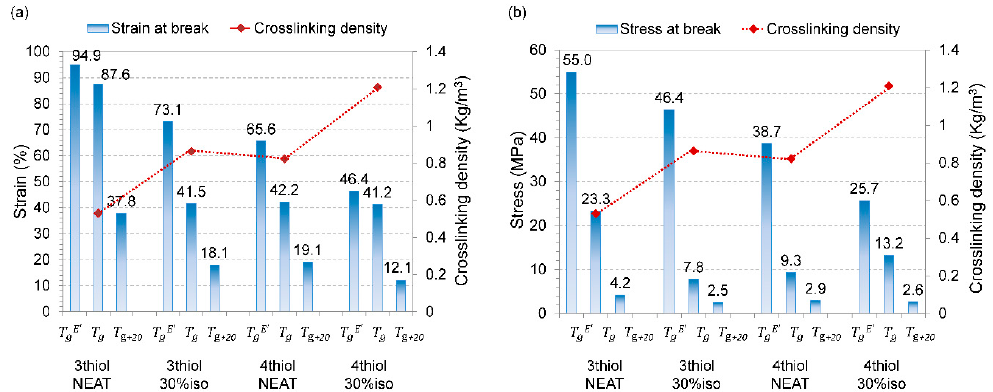
Figure 9. Mechanical response and crosslinking density as a function of the programming temperature for all the formulations of study; ( a ) strain at break values; ( b ) stress at break values. Overall, it should be pointed out the mechanical performance of these materials, in terms of σ b and ε b , they are superior to other epoxy-based SMPs. Williams et al. [14] reported an epoxy-amine system (based on a long aliphatic chain n -dodecylamine) with large tensile elongations (up to 75%) and high recovered stresses (over 4 MPa), when programming at a temperature close to the T g . Rousseau et al. [10] reported epoxy-amine systems (based on long flexible polyetheramines) with higher values of σ b (up to 8 MPa) and large ultimate strain (over 60%), when programming at T g E ′ , the optimal mechanical point. In addition, our group [15] reported epoxy-amine materials (based on polyetheramines and hyperbranched poly(ethyleneimine)s) with σ b over 12 MPa while maintaining large ultimate strain ( ε b up to 60%). In general terms, while the tensile elongation is enhanced by adjusting the programming temperature and the network structure, the mechanical work remains limited by the low tensile strength obtained. In the present case, the thiol-epoxy materials under study fulfil both the requirements of high tensile strain and enhanced tensile stress, thus, enhancing the energy storage capacity and therefore the expected performance on constrained experiments [40]. The 3thiol-NEAT system reaches values of almost 100% of ε b (comparable with those reports by the mentioned authors [10,14,15]) and 55 MPa of σ b (which is over 4 times higher than those reported